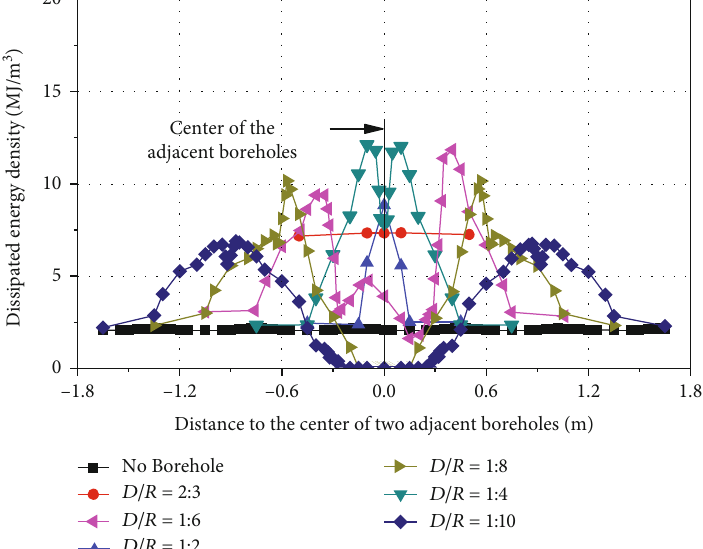
Figure 8: DED distributing curves between the neighboring boreholes at X = 7 : 5 m in Y direction under di ff erent D / R ratios. The data were extracted from the B-B ′ section in Figure 5(a). The “ 0 ” point indicates the midpoint of the circle center line of the adjacent